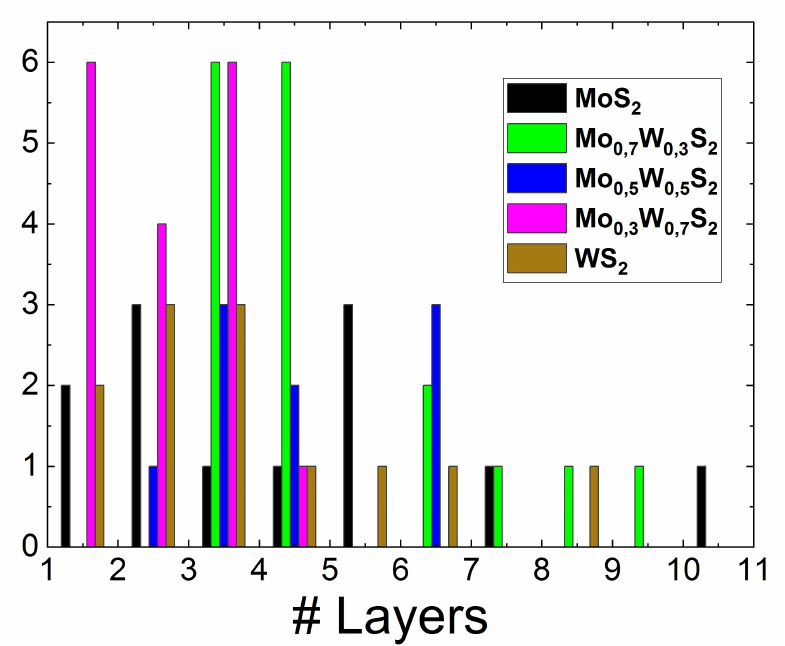
Figure A2. Histogram showing the number of layers measured for each region of interest in each alloying degree (Mo